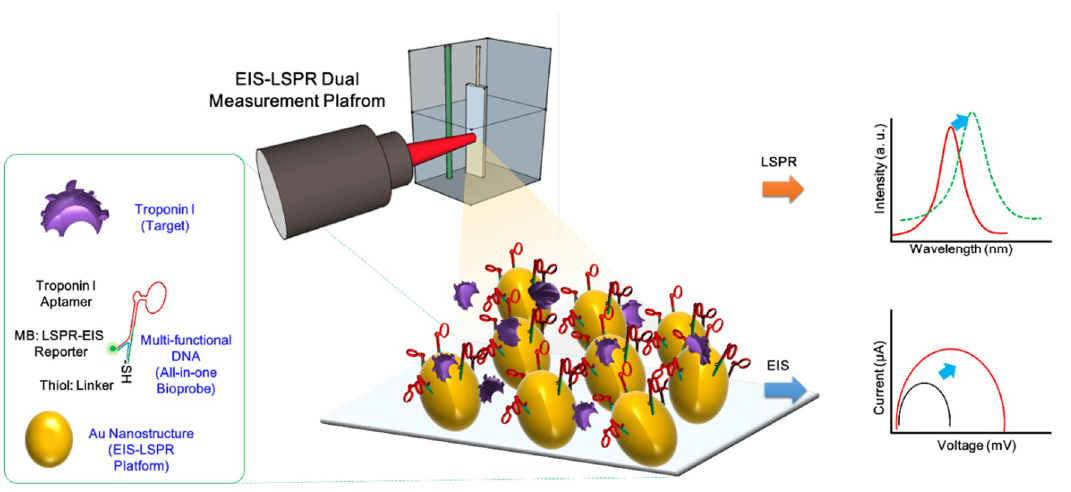
Figure 1. Schematic image of the fabricated electrochemical method (EC) localized surface plasmon resonance (LSPR) biosensor for cardiac troponin I (cTnI) detection.